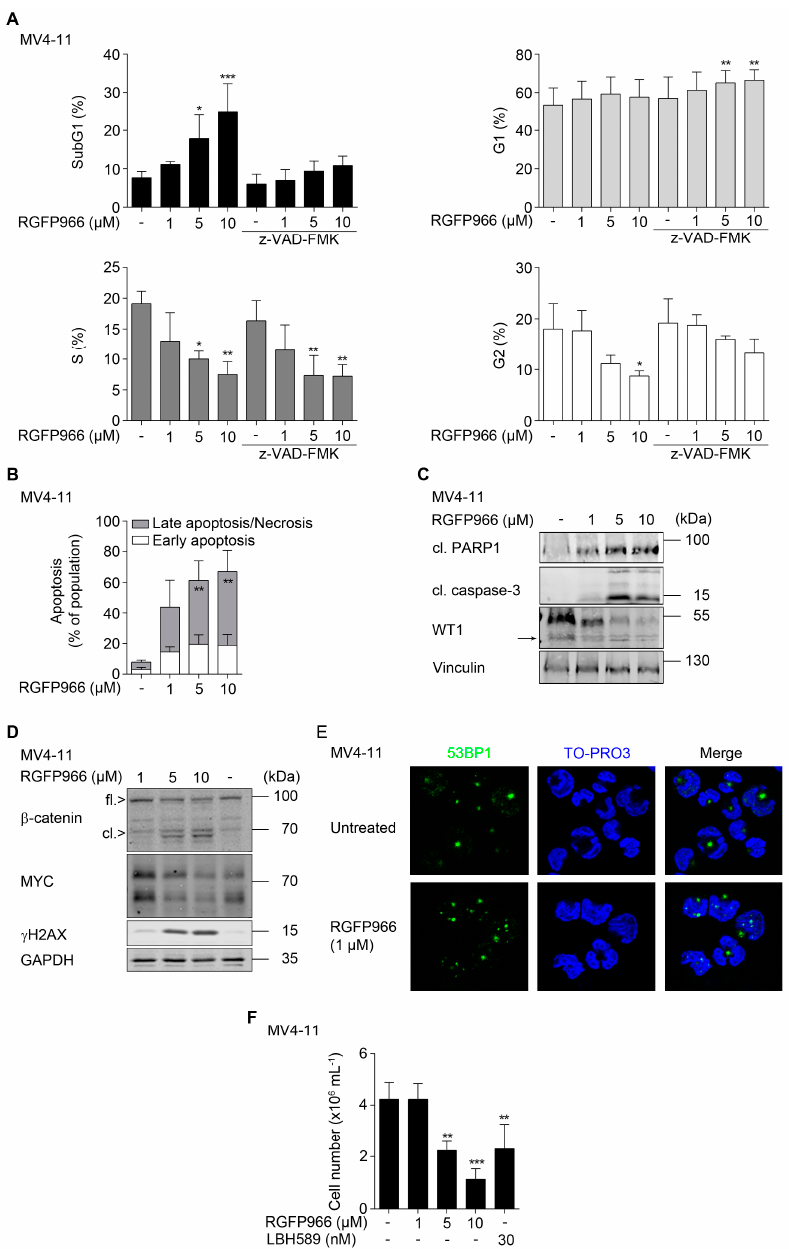
Figure 4. Biological consequences of HDAC3 inhibition and interplay between β -catenin, MYC, and WT1. ( A ) MV4-11 cells were pretreated with z-VAD-FMK for 1 h, followed by incubation with RGFP966 as indicated for 24 h. Cells were fixed and stained with PI and analyzed by flow cytometry ( n = 3; mean + SD; two-way ANOVA; * p ≤ 0.05; ** p ≤ 0.01; *** p ≤ 0.001). ( B ) MV4-11 cells were treated as indicated for 24 h. After incubation time, cells were stained with annexin-V-FITC / PI and apoptosis was determined by flow cytometry ( n = 3; mean + SD; two-way ANOVA; ** p ≤ 0.01). ( C ) MV4-11 cells were treated with increasing doses of RGFP966 (1 µ M, 5 µ M, and 10 µ M) for 24 h. Caspase-3, PARP1, and WT1 ( → marks WT1 cleavage product) were analyzed by Western blot, with vinculin as loading control ( n = 2). ( D ) MV4-11 cells were treated as stated in ( C ). Indicated proteins were detected via Western blot, with GAPDH as loading control ( n = 2). ( E ) Immunofluorescence for 53BP1 in MV4-11 cells that remained untreated or exposed to 1 µ M RGFP966 for 24 h. ( F ) MV4-11 cells were treated as indicated for 24 h. Thereafter, cells were harvested and washed with PBS and reseeded. After 4 days, the cell numbers were determined by trypan blue staining and counting ( n = 3; mean + SD; one-way ANOVA; ** p ≤ 0.01; *** p ≤